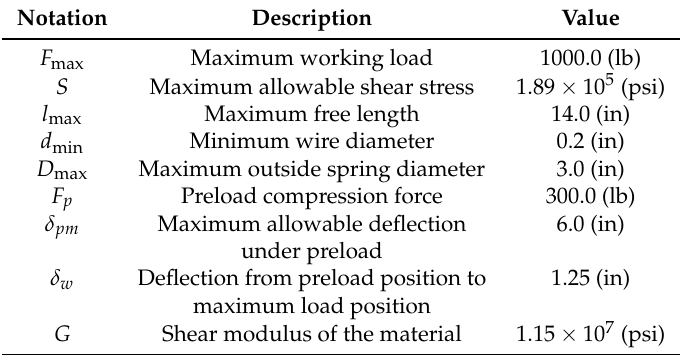
Table 5. Parameter values used in the formulation of the helical compression spring problem.